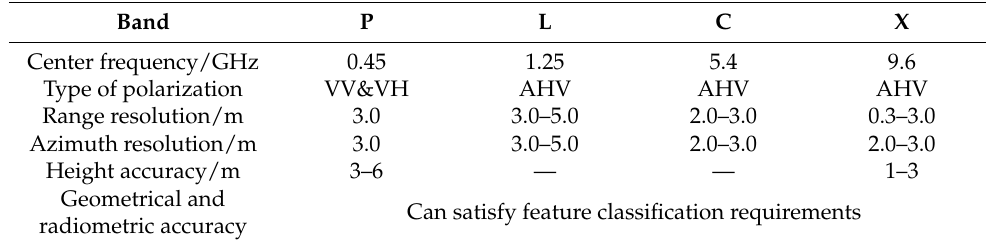
Table 1. Multi-band fully polarimetric SAR